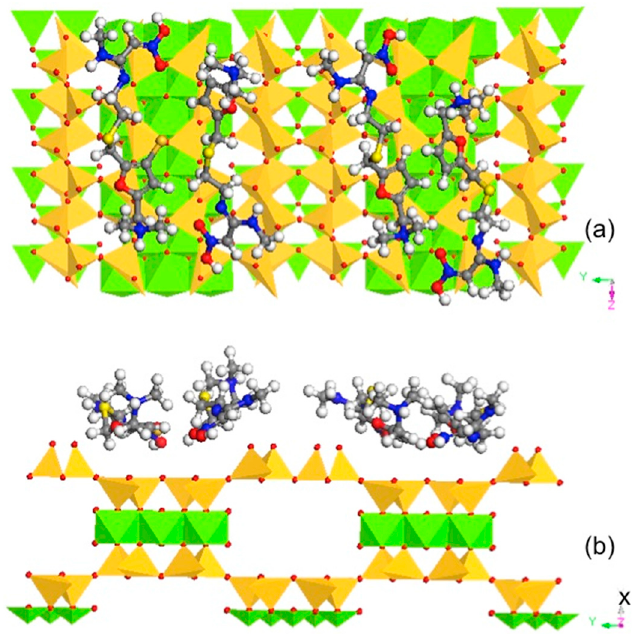
Figure 4. Molecular dynamic simulation showing the monolayer surface configuration of sorbed RT on Pal along ( a ) [100] and ( b ) [001] directions.